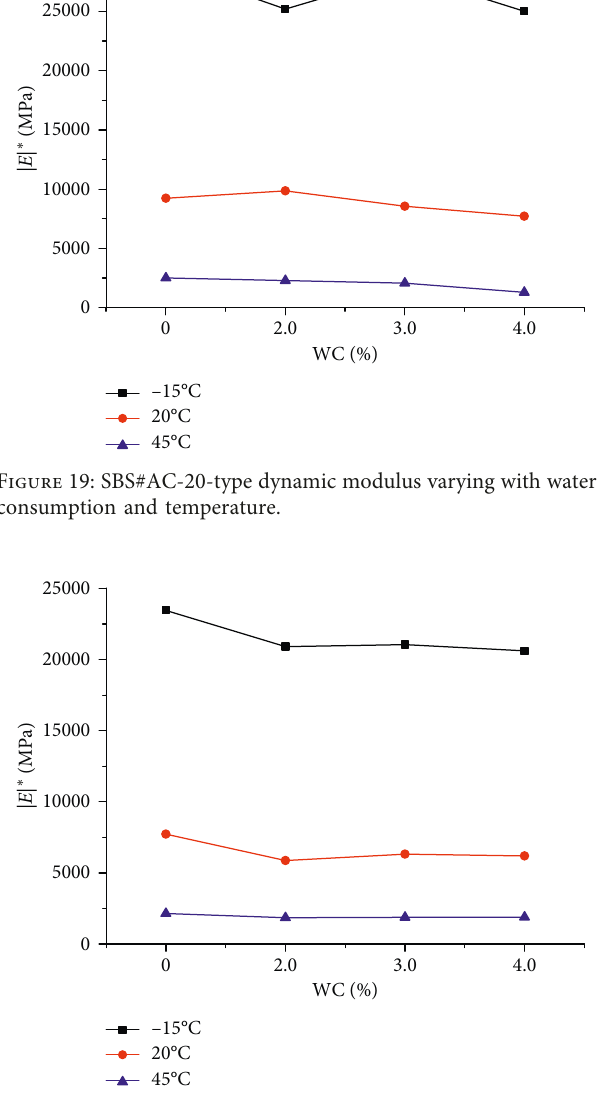
Figure 20: SBS#AC-13-type dynamic modulus varying with water consumption and temperature.